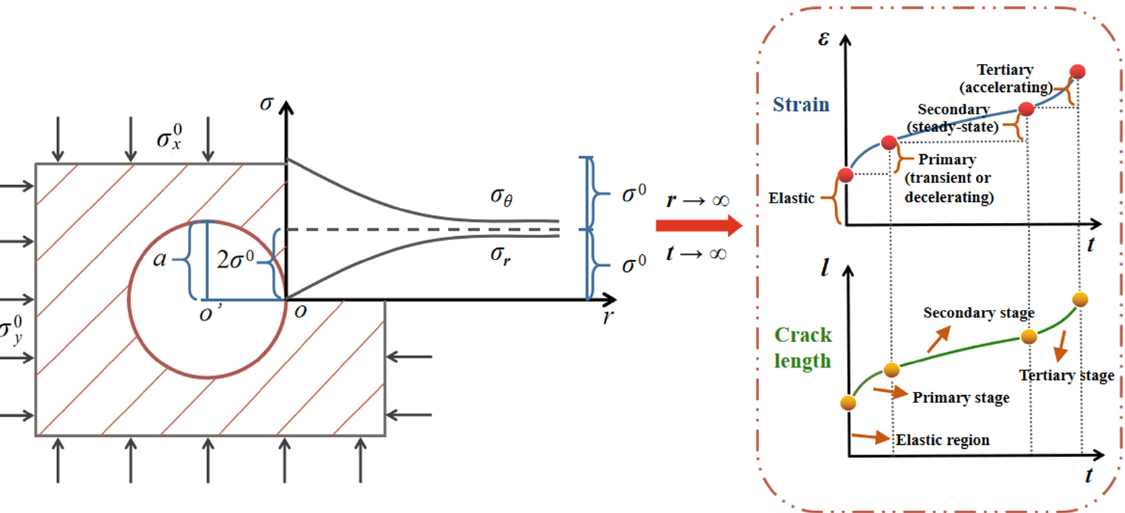
Figure 7. Time-dependent evolution of crack length and strain with distance from the center of tunnel section in the elastic analytic model.